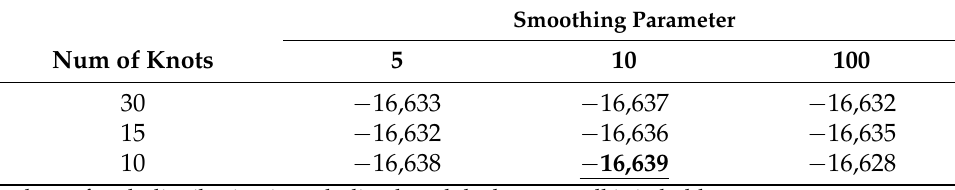
Table 22. DIC for Weibull distribution (23 June 2016, JAL, Tokyo, Japan).